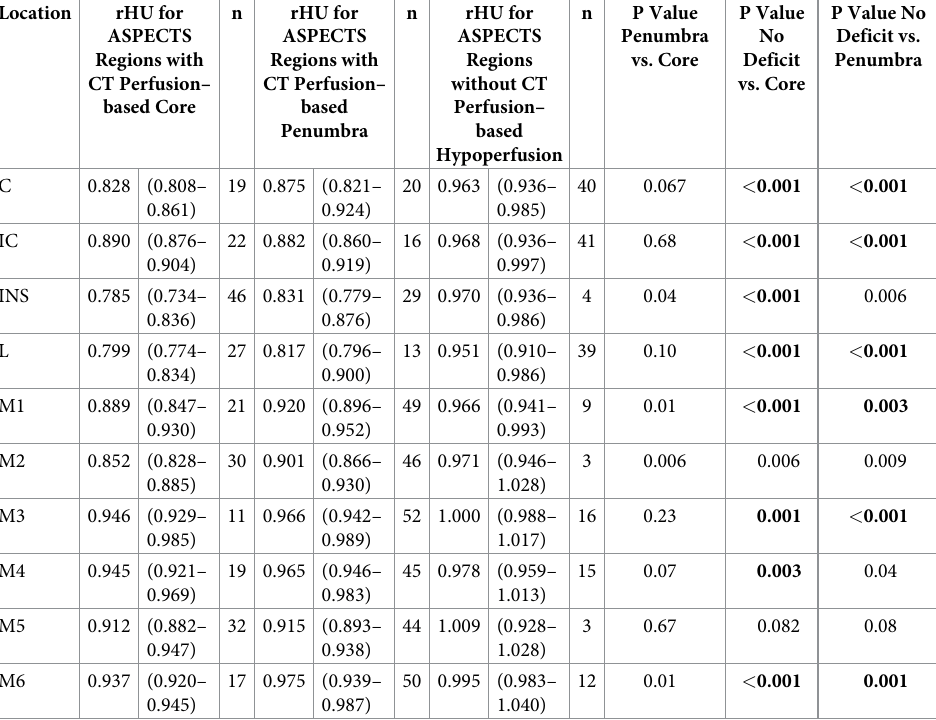
rHU values are displayed as median (interquartile range). Ischemic core was defined as ischemic change on the parametric cerebral blood flow map as well as cerebral blood volume map. Penumbra was defined as ischemia on the cerebral blood flow maps without matching changes on cerebral blood volume maps. C indicates caudate nucleus; IC, internal capsule; INS, insula; L, lentiform nucleus; M1-M6, cortical regions of the ASPECTS score; rHU, relative Hounsfield Units; ASPECTS, Alberta Stroke Program Early CT Score. P Values < 0.05 indicate statistical significance. Bold values indicate significance after correction for multiple comparisons using Bonferroni’s